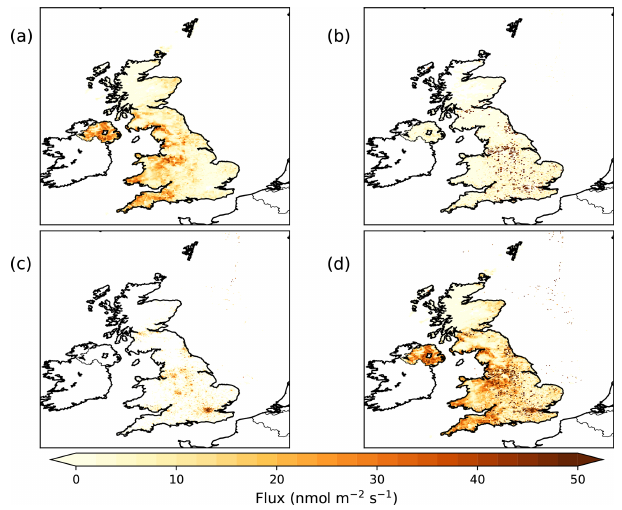
Figure 2. Maps showing the spatial distribution of the NAEI emis- sions in the UK at 5 × 5km resolution, showing the (a) agriculture sector, (b) waste sector, (c) energy sector and (d) the total anthro- pogenic